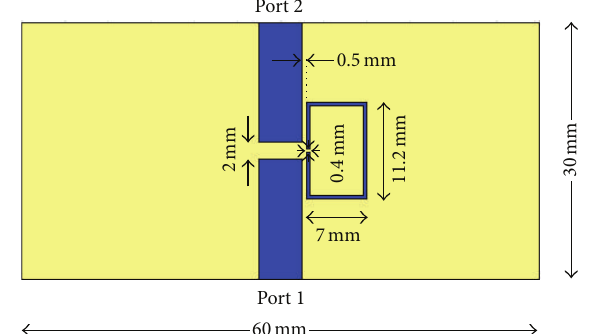
Figure 1: An OLR-based bandpass filter.